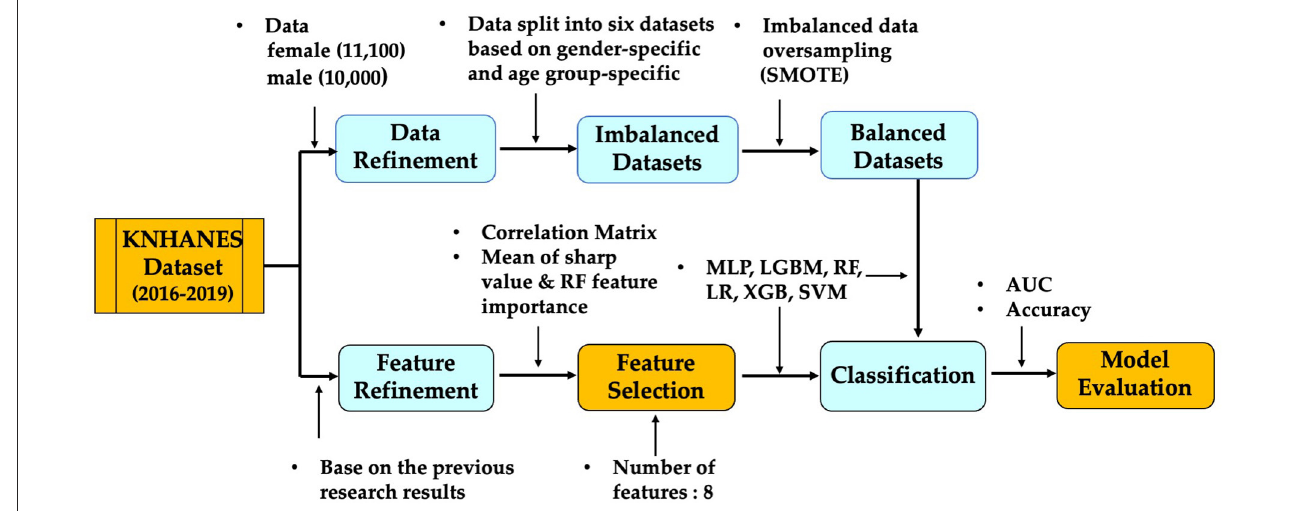
FIGURE2 Schematic diagram for identifying and predicting obesity risk